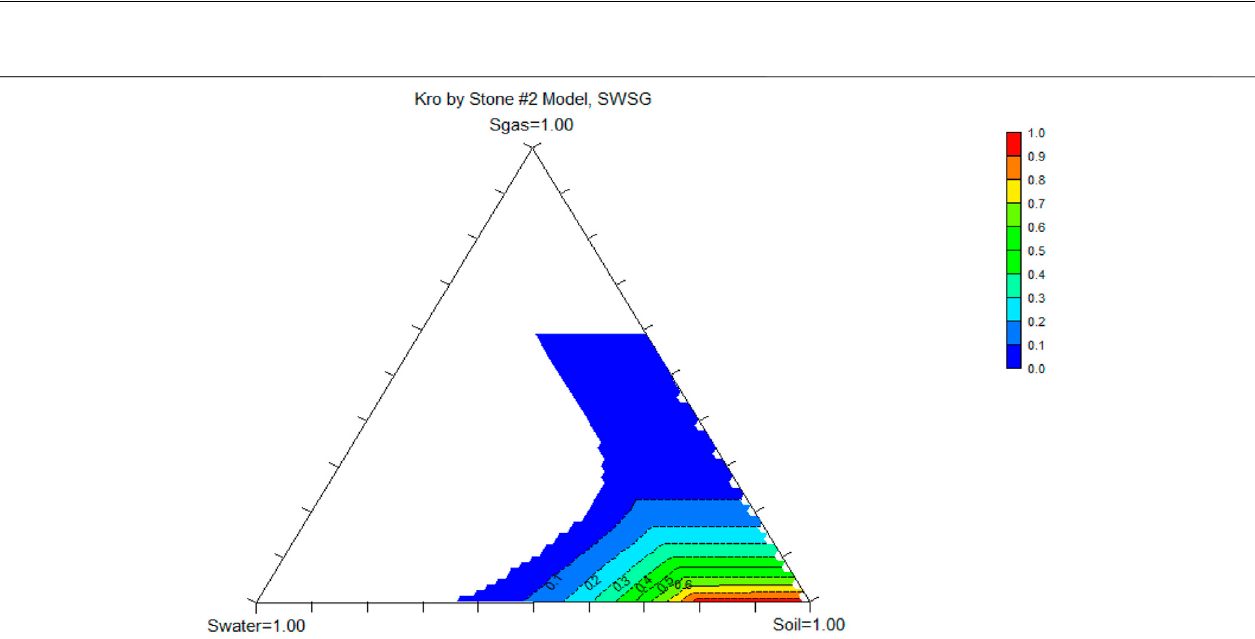
FIGURE 4 | Oil relative permeability as a function of gas, water, and oil